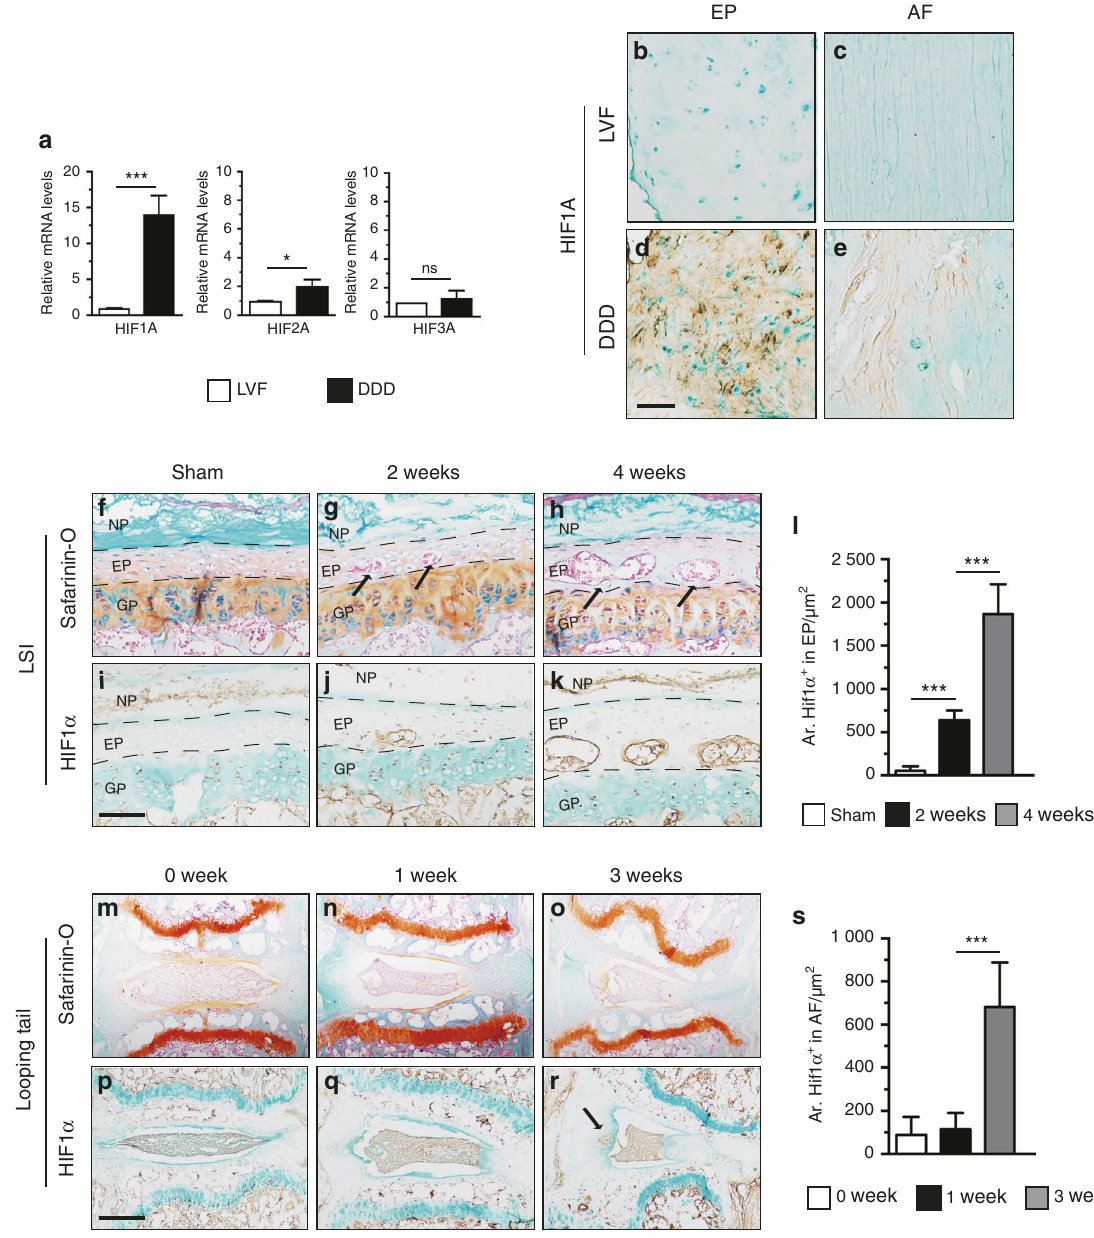
Fig. 1 Upregulated HIF1 α signaling in EP and AF tissues of degenerative IVD. ( a ) Real-time PCR analysis of HIF1A, HIF2A and HIF3A expression in degenerative lumbar EP from patients with DDD. b – e Immunohistochemical detection of HIF1A expression was performed in normal and degenerative lumbar EP and AF tissues. f – h Histological analysis of IVD samples harvested at 2 and 4 weeks post LSI (lumbar spine instability) surgery and by Safranin O/Fast green staining. The arrowheads indicate EP ossi fi cations. IHC staining for HIF1 α was performed in the IVD of wild-type mice. (i) Sham mice, ( j , k ) 2 weeks and 4 weeks after LSI surgery. l Quantitative analysis of the areas of HIF1 α immunoreacted positive cells in LSI surgery. m – o Caudal vertebrae were harvested at 0, 1, and 3 weeks after tail-looping surgery and analyzed histologically by Safranin O/Fast green staining. p – r Immunohistochemical analysis of HIF1 α + cells in tail-looping surgery. The black arrow indicates AF degeneration. s Quantitative analysis of HIF1 α + cells. Scale bar: 100 µm ( b – e ), 50 µm ( f – k ), 100 µm ( m – r ). Data are expressed as the percent expression relative to controls. Values represent the mean (symbols) ± SD (error bars). * P < 0.05; ** P < 0.01; *** P <